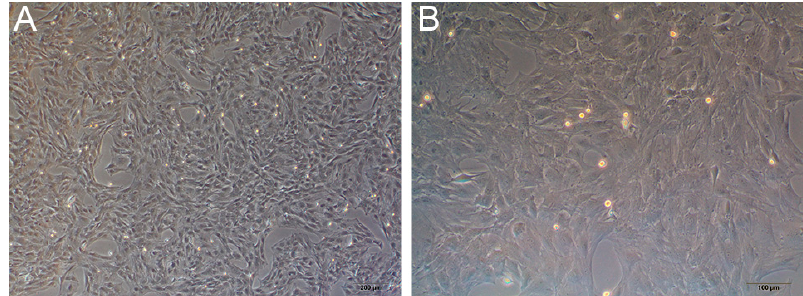
Figure 12. The third generation of primary culture rat BMSCs. ( A ) 40×. ( B ) 100×.